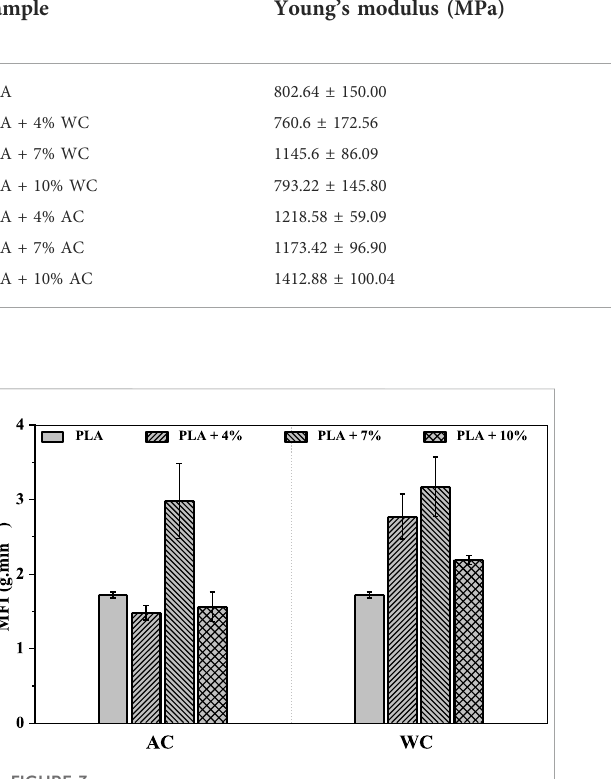
FIGURE 3 Melt fl ow index values of PLA and composites.